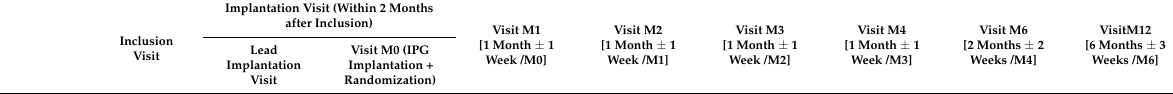
Figure 1. BOOST DRG study design (applicable for phase A and phase B). Table 1. Radio-clinical assessment calendar.